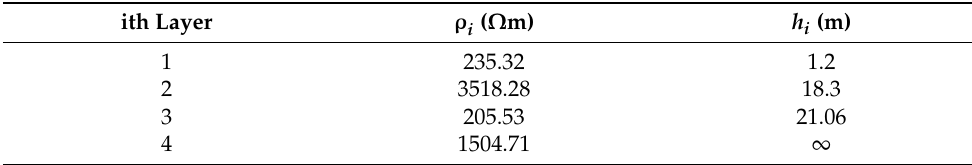
Table 1. Soil parameters of a four-layer structure.